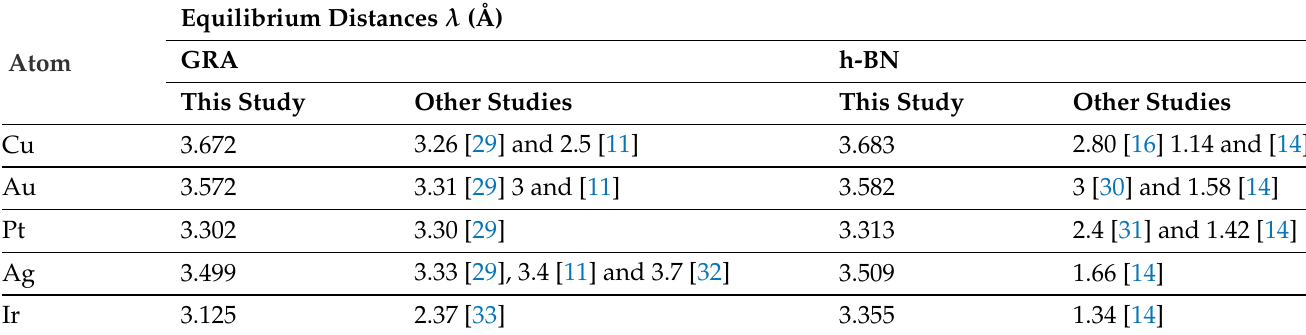
Table 3. Comparison of the values of the equilibrium distances of this study and other studies. Equilibrium Distances λ